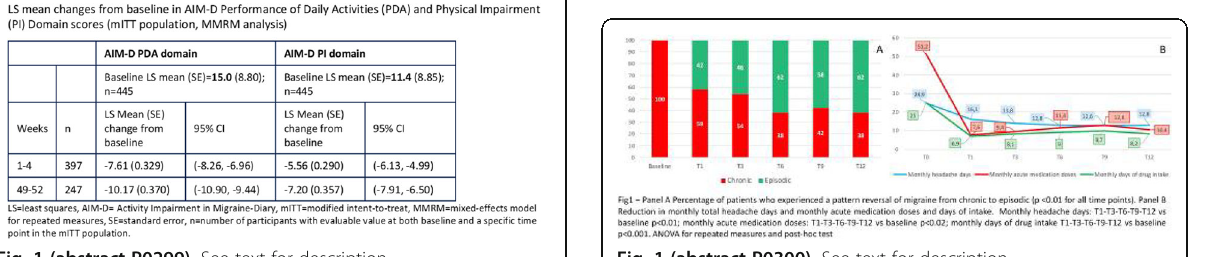
Fig. 1 (abstract P0299). See text for description